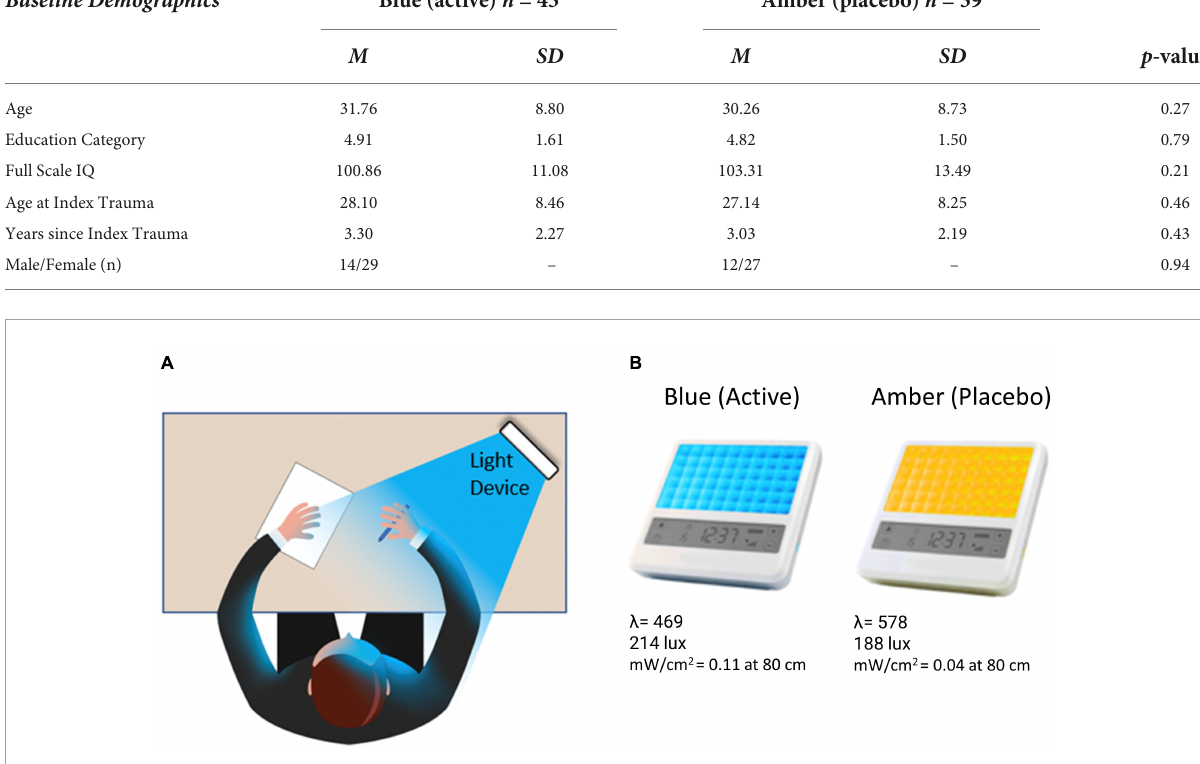
FIGURE1 (A) The participant was instructed to bathe their face with the light for 30-min each morning by placing the light device at arm’s length on a table at an approximately 45-degree angle. (B) Participants received either a blue (active condition) or amber (placebo condition) lightbox fitted with light-emitting